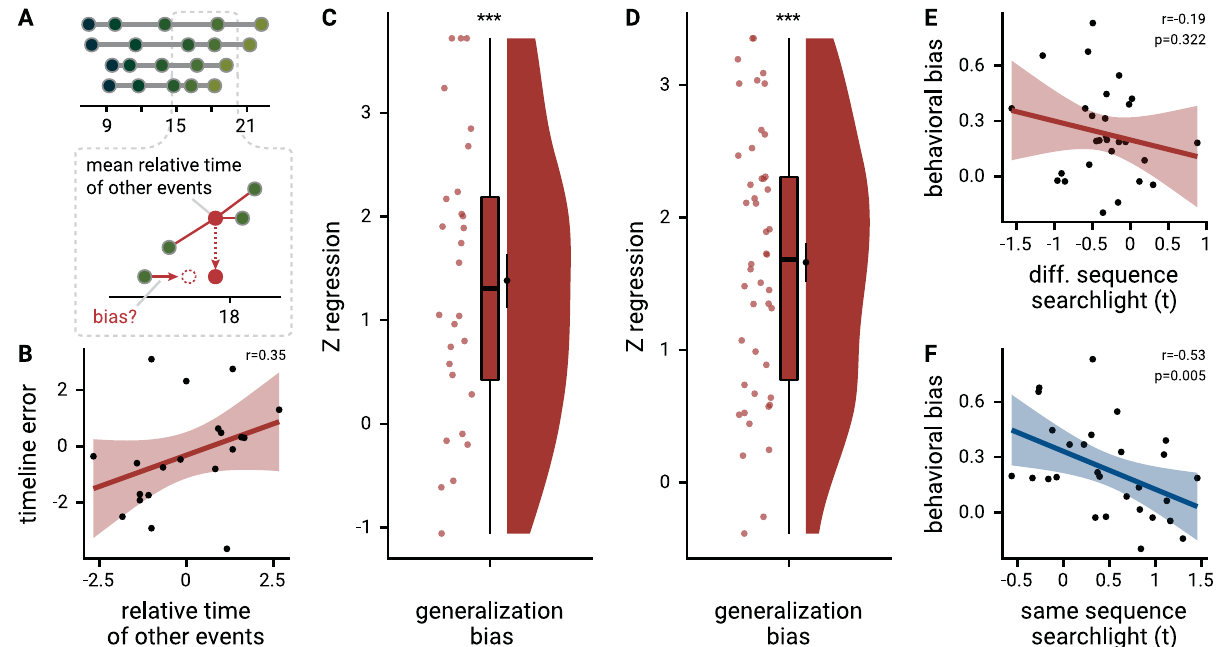
Fig. 8 Structural knowledge biases construction of event times. A The generalization bias quanti fi es the in fl uence of structural knowledge on the construction of individual event times. For each event, the mean time of events at the same sequence position in the other sequences was calculated to test whether event times were biased towards the relative time of other events. B The scatterplot illustrates the generalization bias for an example participant. Each circle corresponds to one event and the regression line highlights the relationship between the relative time of other events and the errors in constructed event times. The example participant was chosen to have a median-strength generalization bias. See Supplementary Fig. 10 for the entire sample. Correlation coef fi cient is based on Pearson correlation. C The relative time of events from other sequences predicted signed event time construction errors as measured in the timeline task. Positive values indicate that when other events took place late relative to a speci fi c event, the time of that event was estimated to be later than when other events were relatively early. Circles show individual participant Z-values from participant-speci fi c linear models ( B ); boxplot shows median and upper/lower quartile along with whiskers extending to most extreme data point within 1.5 interquartile ranges above/below the upper/lower quartile; black circle with error bars corresponds to mean ± S.E.M.; distribution shows probability density function of data points. D The generalization bias in event time construction through structural knowledge was replicated in an independent sample ( n = 46) based on Montijn et al. 66 . Data shown as in C . E The behavioral generalization bias (regression coef fi cients from summary statistics approach) did not correlate signi fi cantly with the across-sequence generalization effect in the anterior hippocampus (searchlight peak voxel t-values). F We observed a signi fi cant negative correlation between the same-sequence searchlight effect (peak voxel t-values) and the behavioral generalization bias (regression coef fi cients from summary statistics approach), suggesting that participants with strong hippocampal representations of the temporal relations between events from the same sequence were less biased by structural knowledge in their construction of event times. Statistics in E and F are based on Spearman correlation. Lines in E and F show least squares lines, shaded regions correspond to 95% con fi dence intervals. Source data are provided as a Source Data fi le. *** p < data show that virtual time explained representational changes when competing for variance with order and real time also for events from different sequences. This makes it unlikely that the hippocampal generalization effect was driven exclusively by events at the fi rst or last sequence position. The generalization of temporal distances across sequences in the hippocampus is in line with the contribution of constructive mnemonic processes to fl exible cog- statistical learning 13,40,43,46,48,49,68,69 . More generally, it is con-